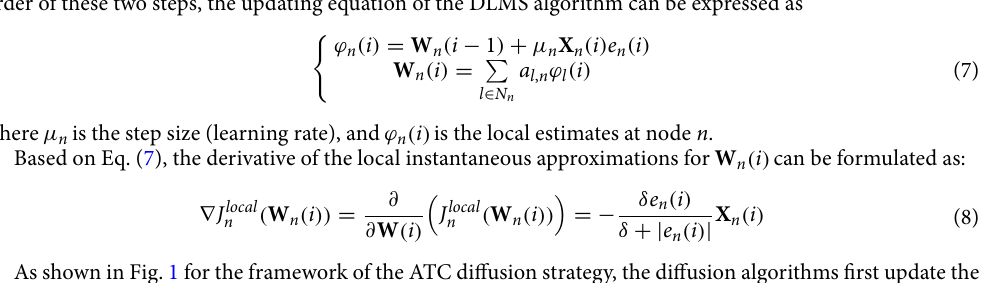
where the set of nodes that are connected to n (including n itself) is denoted by N n and is called the neighbor- hood of nodes n . The weighting coefficients a l , n are real and satisfy The DLMS algorithm obtains the estimation via two steps, adaptation and combination. According to the order of these two steps, the updating equation of the DLMS algorithm can be expressed as